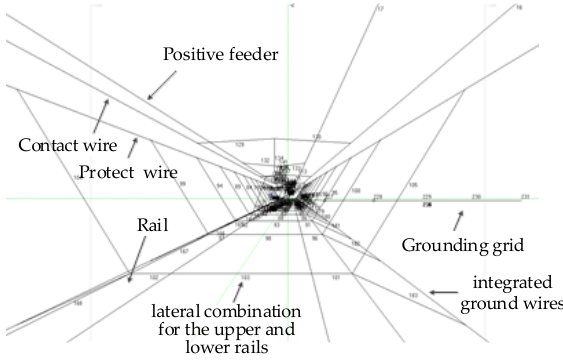
Figure 4. CDEGS traction power supply system model.